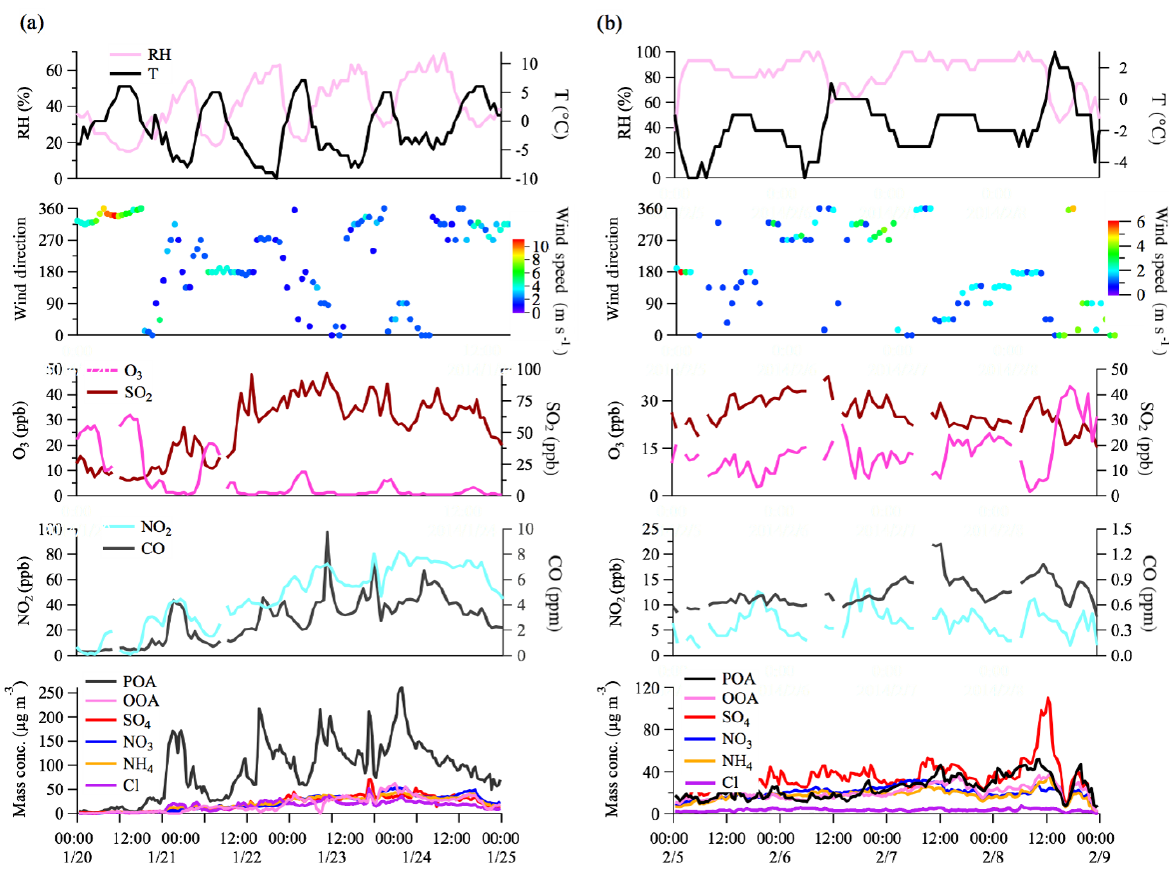
Figure 9. Time series of meteorological factors (relative humidity, temperature, wind speed, and wind direction), gaseous species, OA factors, and NR-PM 1 chemical composition for the first period (average RH < 50%) (a) and the second period (average RH > 80%) (b)